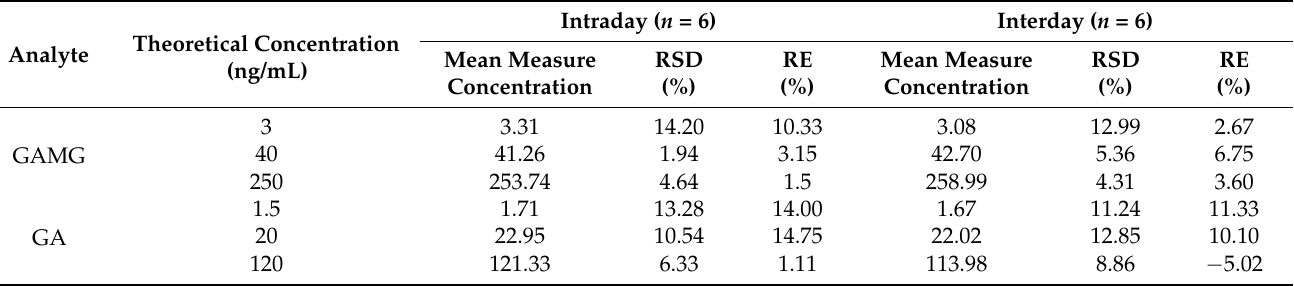
Table 3. Intra-assay and inter-assay precision and accuracy of each analyte ( n =